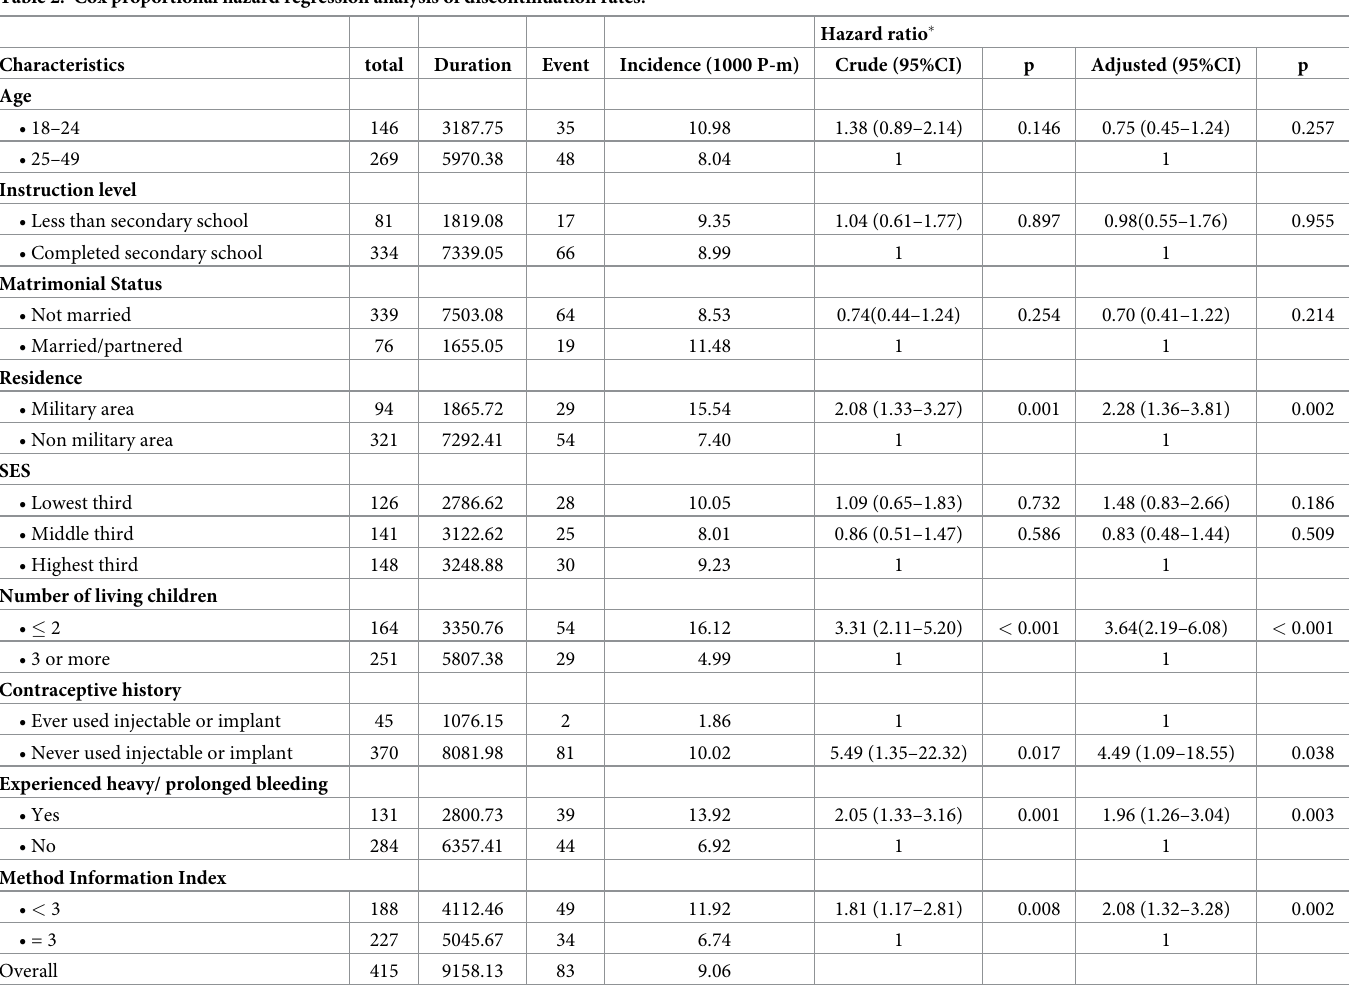
Table 2. Cox proportional hazard regression analysis of discontinuation